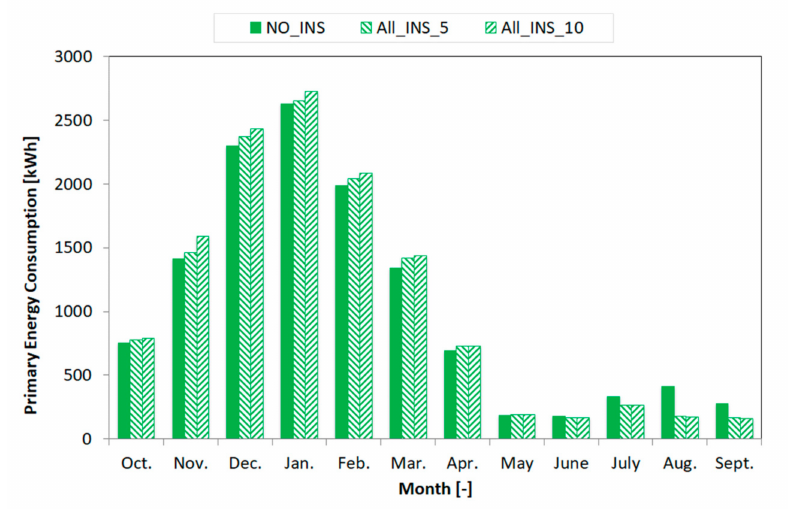
Figure 6. Comparison of all the insulated